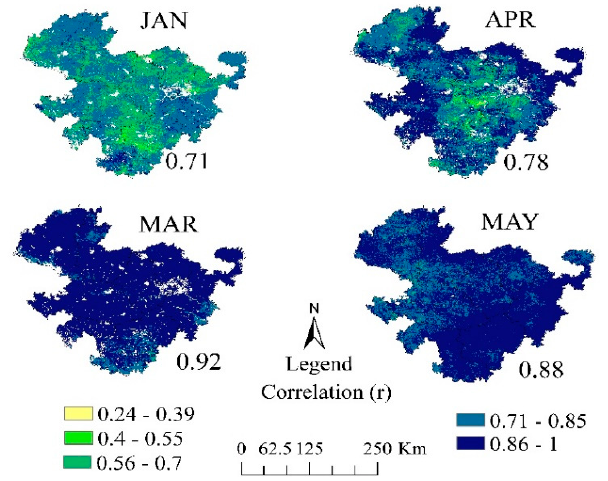
Figure 6. Correlation coefficient values (highest and lowest average months) between results of CDI_M, derived from Method-I and Method-II (bottom right values of each month indicates the average correlation coefficient value over the study area) .